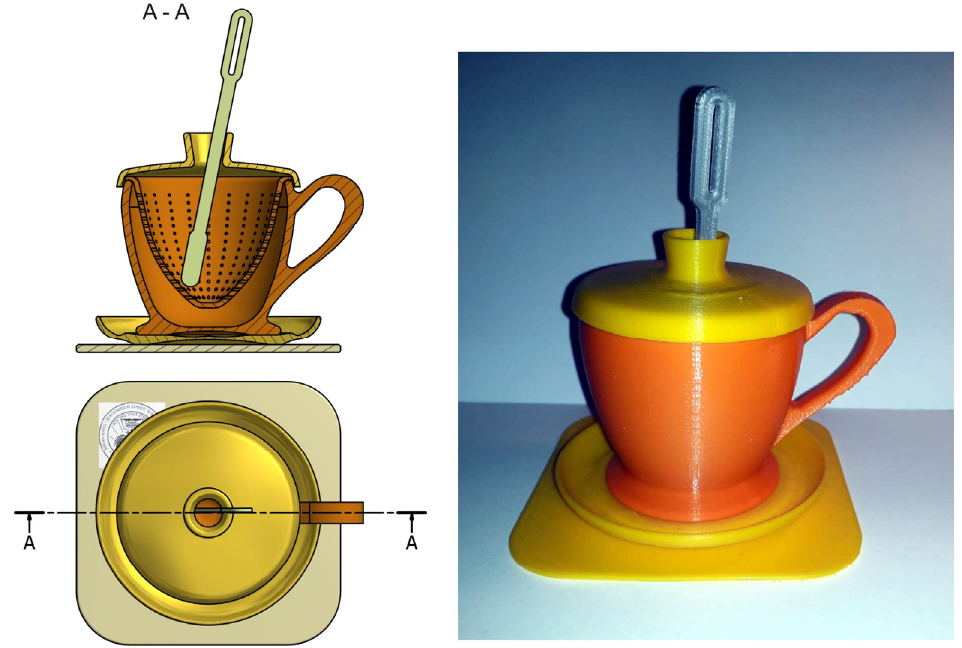
Figure 10. Children’s toy set—teacup. Ensemble and section A-A.